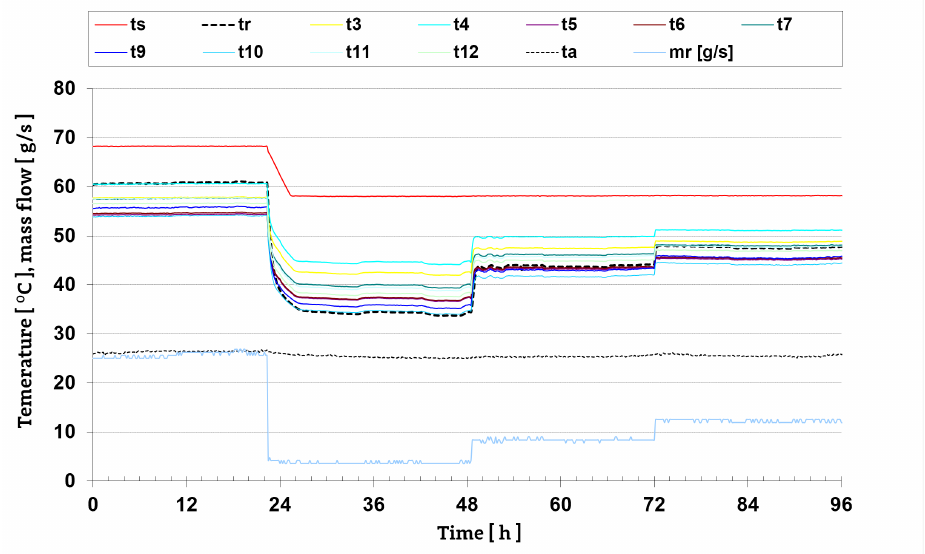
Figure 9. Measuring series V.